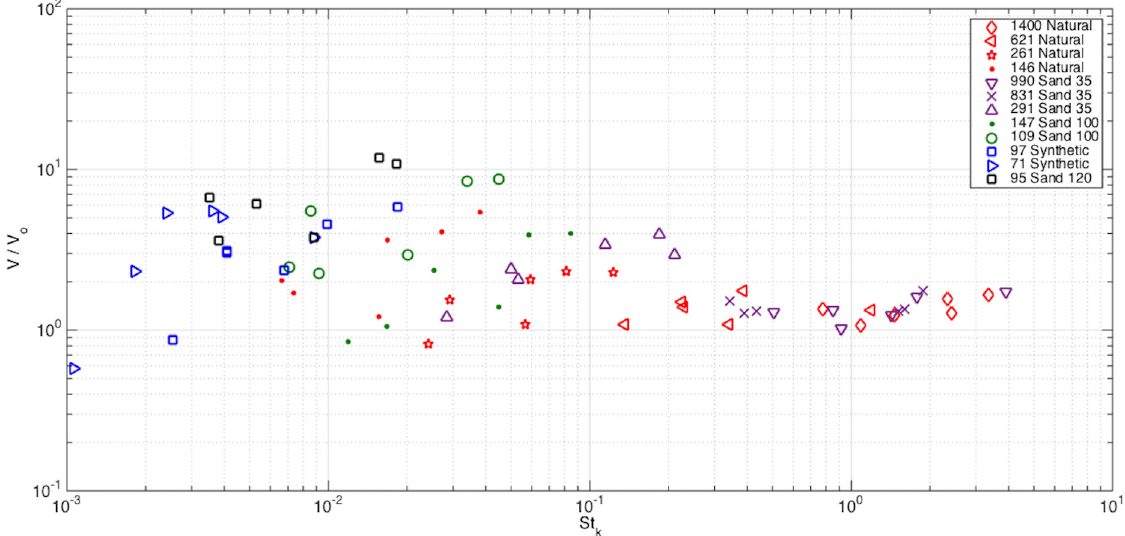
Fig 11. Normalized settling velocity of particles versus Stokes number based on Kolmogorov time